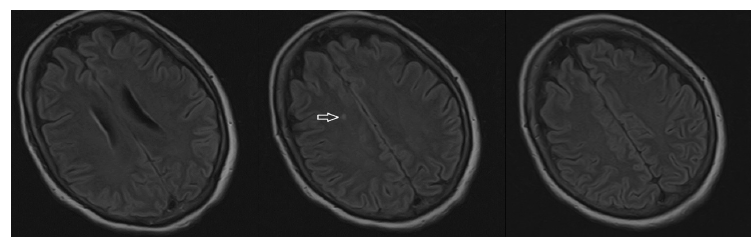
Three fluid-attenuated inversion recovery (FLAIR) magnetic resonance imaging (MRI) axial slices of the brain without gadolinium. Arrow: Single area of localized hyperintensity involving the right centrum se- miovale above the lateral